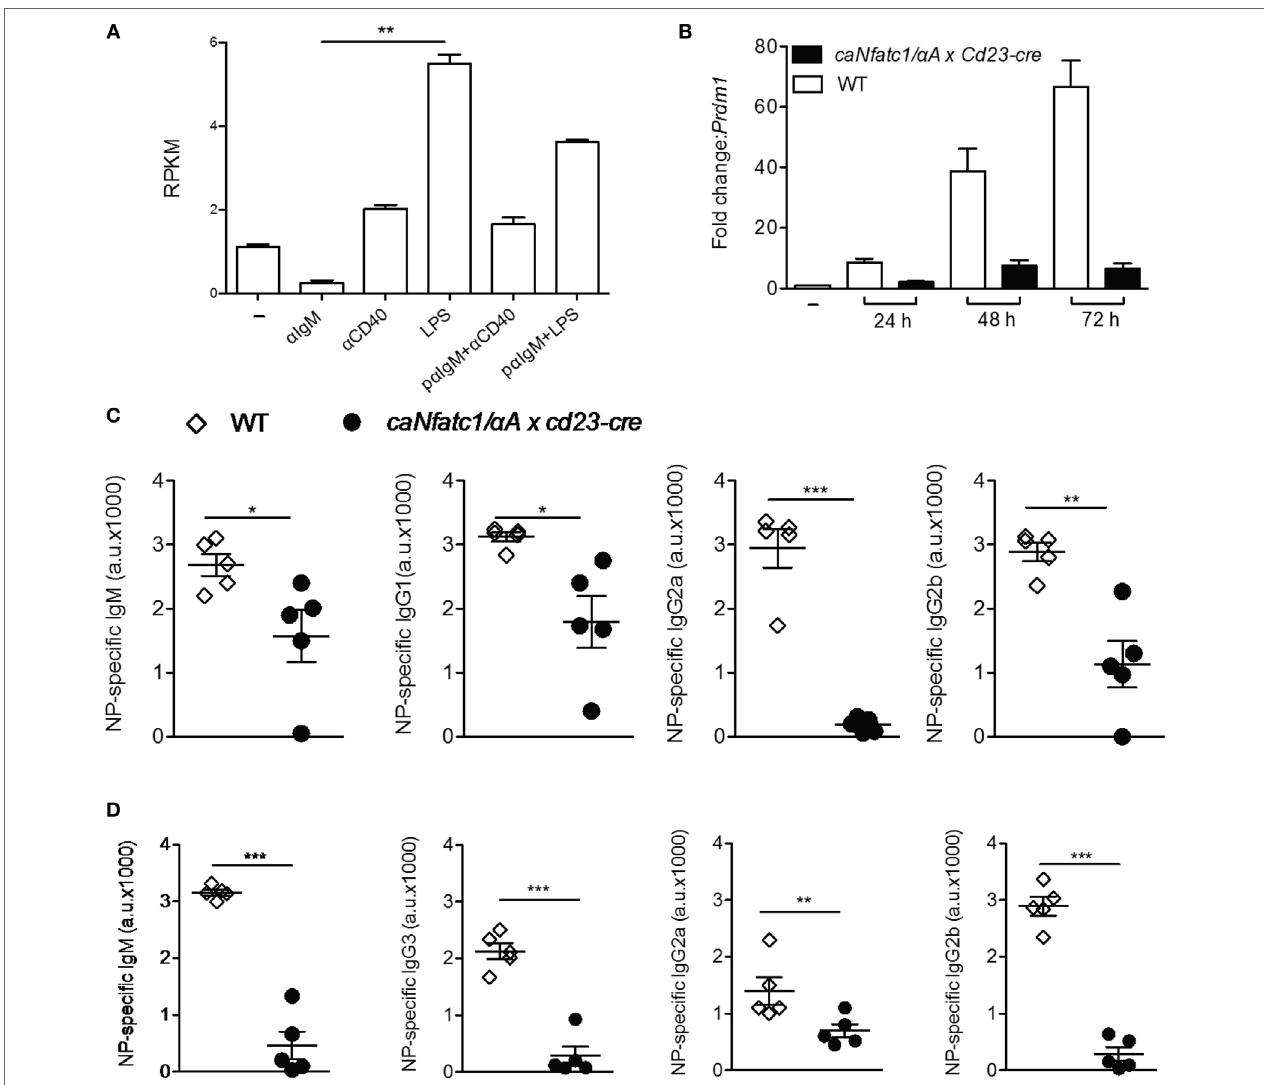
FigUre 4 | Suppression of plasmablast differentiation and of IgG class switch by caNFATc1/ α A. (a) Changes in Prdm1 RNA levels in splenic B cells upon stimulation with α -IgM, α -CD40, or LPS for 24 h. p α IgM: cells were “pulsed” for 30 min at 4°C with α -IgM, washed and then treated with α -CD40 or LPS for 24 h. Shown are mean values of Prdm1 RNA reads (RPKM) from two assays. (B) Splenic B cells from wild-type (WT) mice (open columns) or caNfatc1/ α A × Cd23-cre mice (black) were treated for 24–72 h with LPS. Real-time PCR assays for detecting Prdm1 RNA levels. Mean values of three assays are shown. (c,D) WT and caNfatc1/ α A × Cd23-cre mice were immunized with NP-KLH (c) or NP-Ficoll (D) for 21 days, and the serum levels of immunoglobulins were determined in ELISAs. One dot and square indicates one mouse,